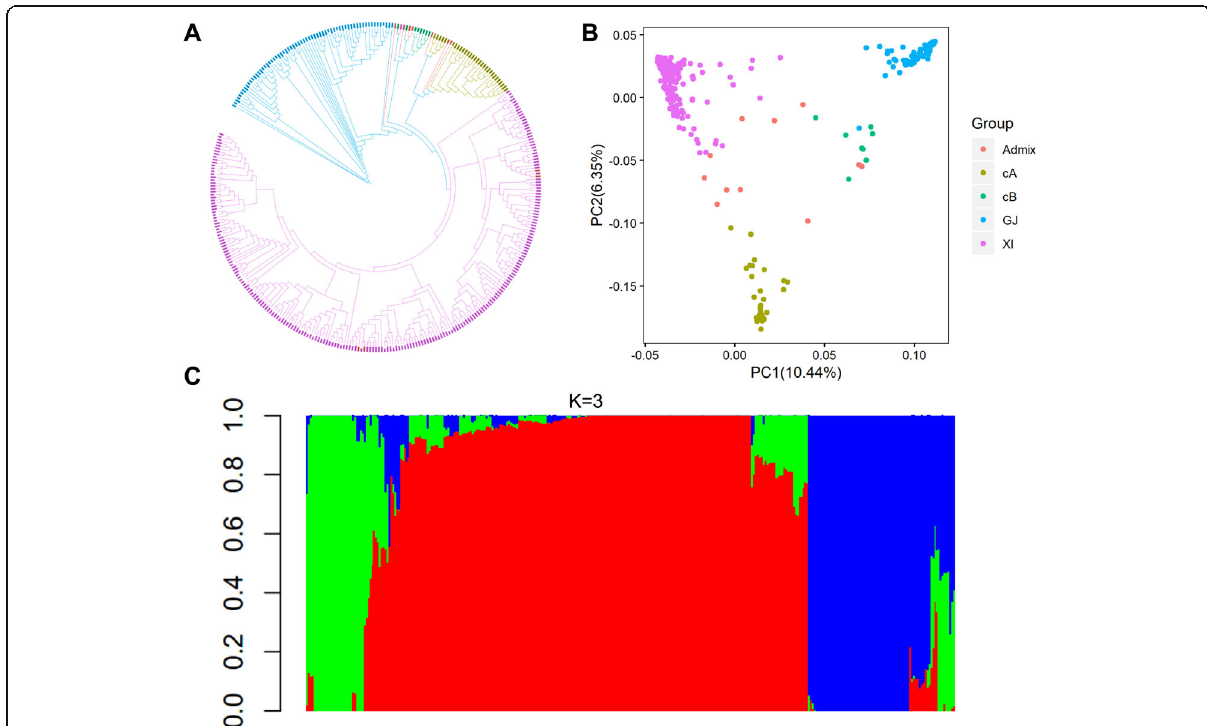
Fig. 1 Population structure analysis of the diverse rice panel used in this study. a Phylogenetic tree of 340 rice accessions. b Principal component analysis for the first two components of 340 accessions. c Distribution of the estimated subpopulations component for individual